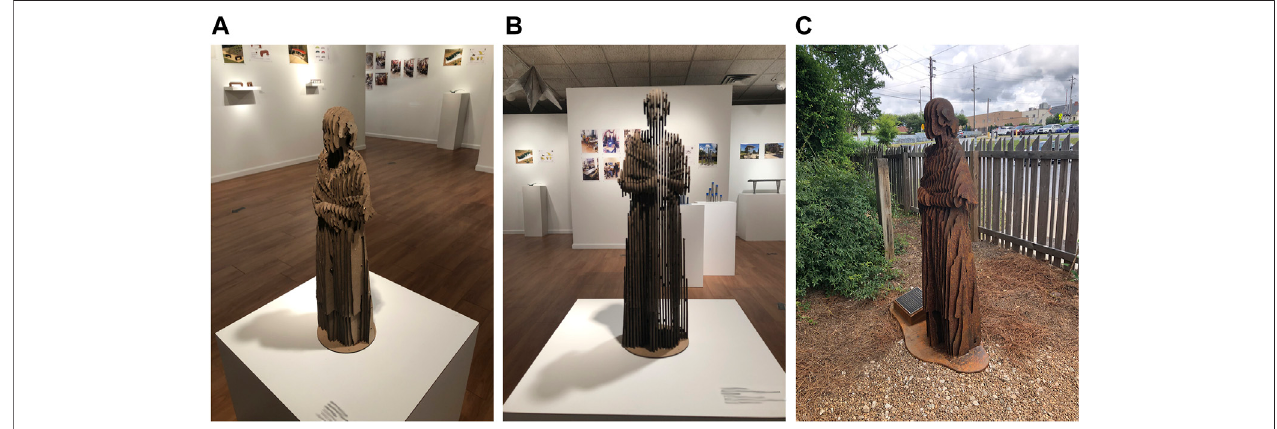
FIGURE2| 3Dsculpture created byartstudentsaspartofavisualartscourse. Photosinclude: (A) 3Dprintedmodelofsculpture (sideview), (B) 3Dprintedmodel of sculpture (front view), and (C) full-sized monument cut with a water-jet